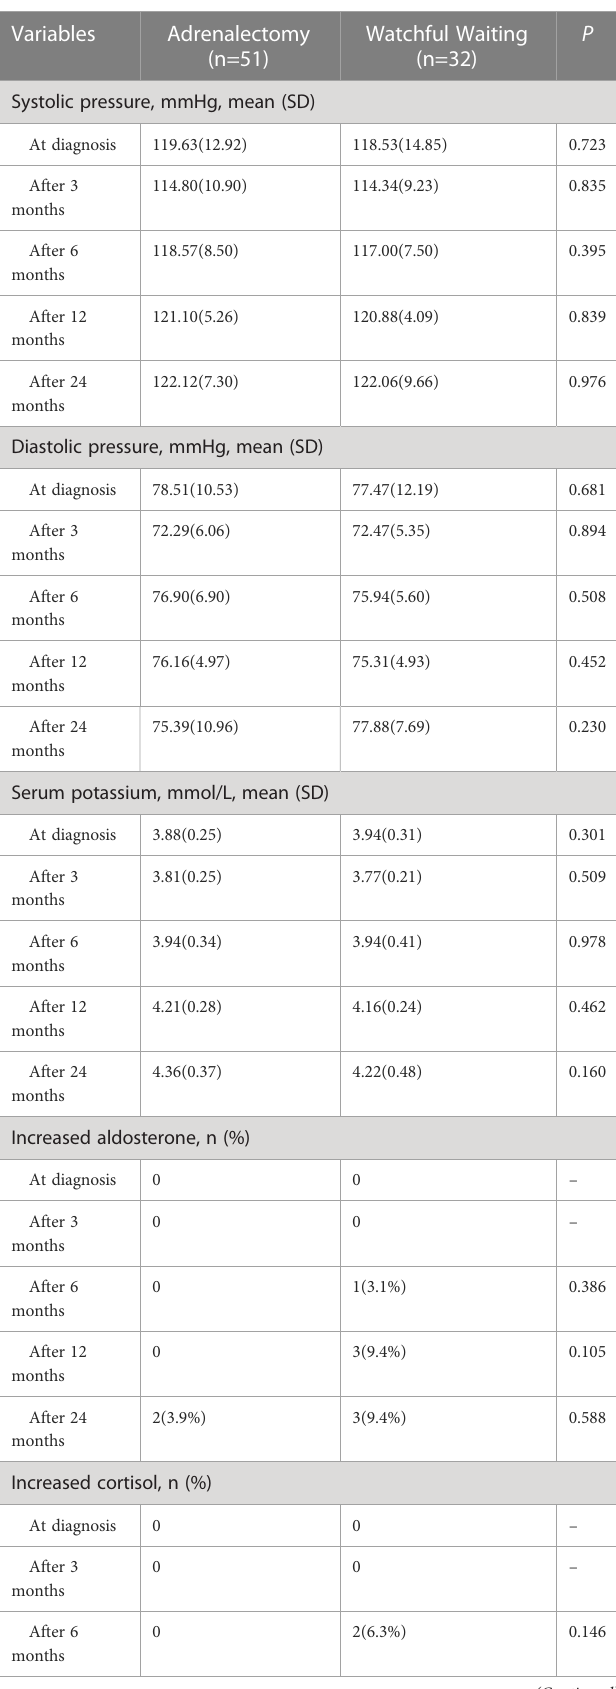
TABLE 2 Comparison of follow-up results of adrenalectomy group and watchful waiting